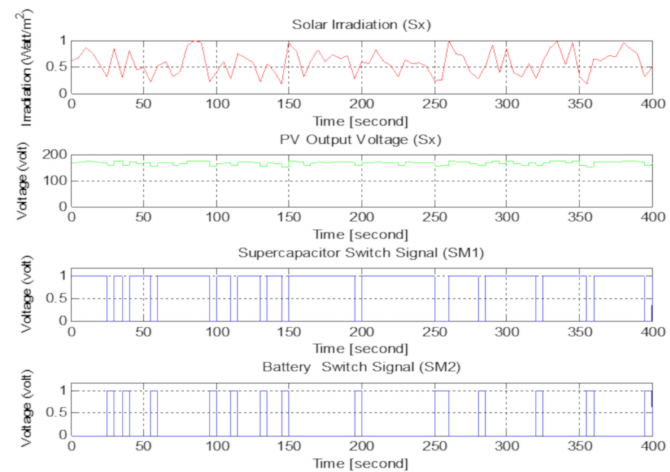
Figure 12. Simulation results of the solar irradiation ( S x ), PV output voltage variation with time, supercapacitor, and battery switch signals for power-sharing.